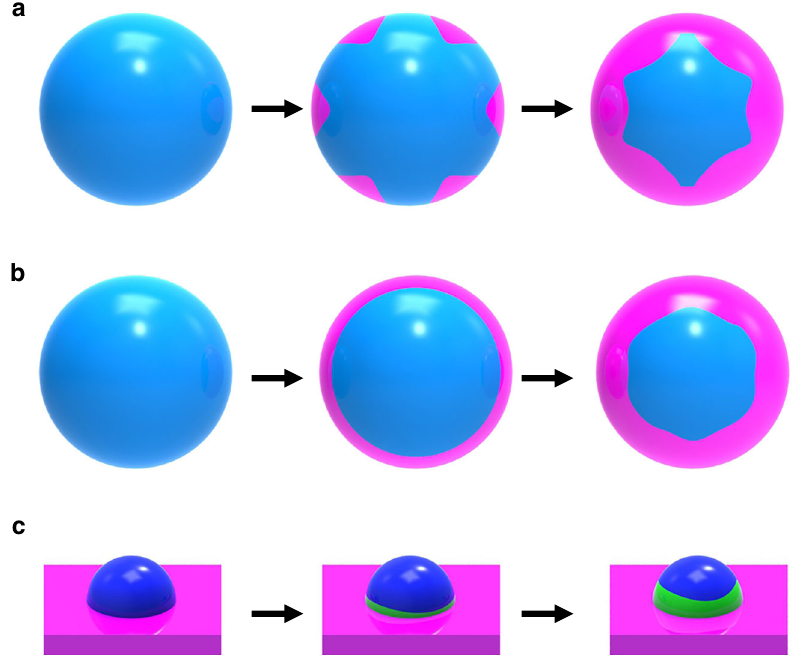
Fig. 4 Schematic comparison of the oxide reduction models. a The nucleation and growth model, generation of small nuclei (denoted by pink color ) of the reduced phase (e.g., a lower valence state oxide or pure metal) occurs on the parent oxide ( blue ) and the reaction interface increases until growing nuclei coalesce and then decreases. b The interface model, rapid formation of a uniform layer of a reduced phase ( pink ) on the parent oxide ( blue ) occurs very soon after contacting with a reducing gas. The reaction interface advances inward uniformly as the reaction proceeds, resulting in a spherical core of the oxide that shrinks with time. c Reduction of an oxide island ( dark blue ) on a metal support ( pink ), formation of the reduced phase ( green ) occurs preferentially at the buried metal/oxide interface